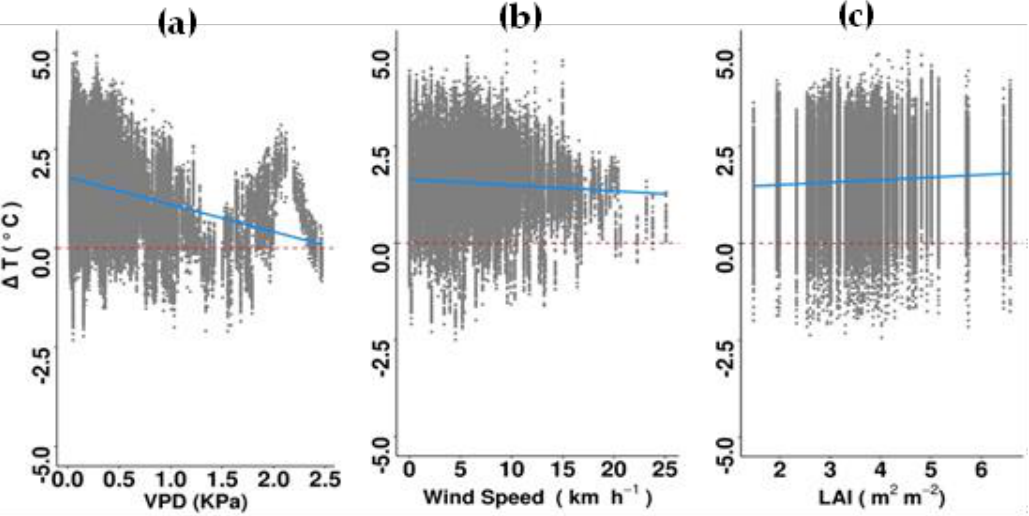
Figure 7. Relationships between Δ T and ( a ) vapor pressure deficit (VPD), ( b ) wind speed and ( c ) leaf area index at nighttime, using all recorded data from 96 individual trees over a three-month period. Only the first three strongest relationships with high chi-square ( X 2 ) values are shown. The dashed red lines indicate no difference between the sub-canopy and ambient air temperatures and the solid blue lines represent regression slopes. There was a total of 106,560 data points. Only significant relationships are shown. For detailed results of the lmer model see Supplementary Table S4.